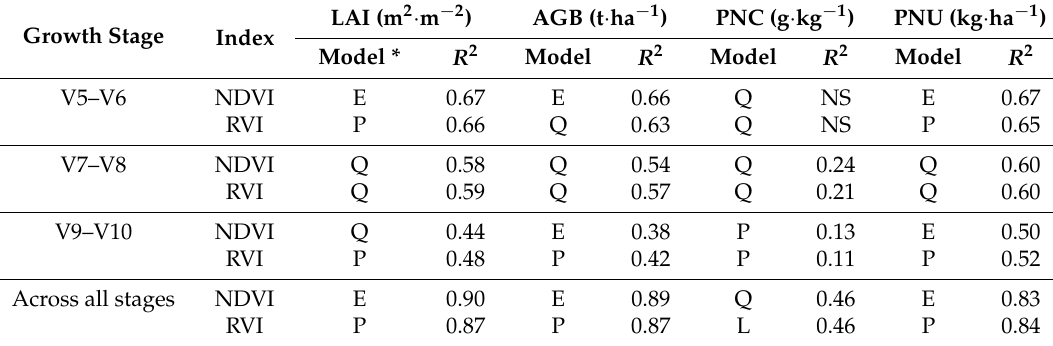
Figure 5. Relationships between leaf area index (LAI) and GreenSeeker sensor-based normalized difference vegetation index (NDVI) ( a ) or ratio vegetation index (RVI) ( b ) across V5 to V10 growth stages in 2014–2015. Table 3. Coefficients of determination ( R 2 ) for the relationships between GreenSeeker indices (normalized difference vegetation index (NDVI) and ratio vegetation index (RVI)) and spring maize leaf area index (LAI), aboveground biomass (AGB), plant N concentration (PNC) and plant N uptake (PNU) at different growth stages across 2014 and 2015.